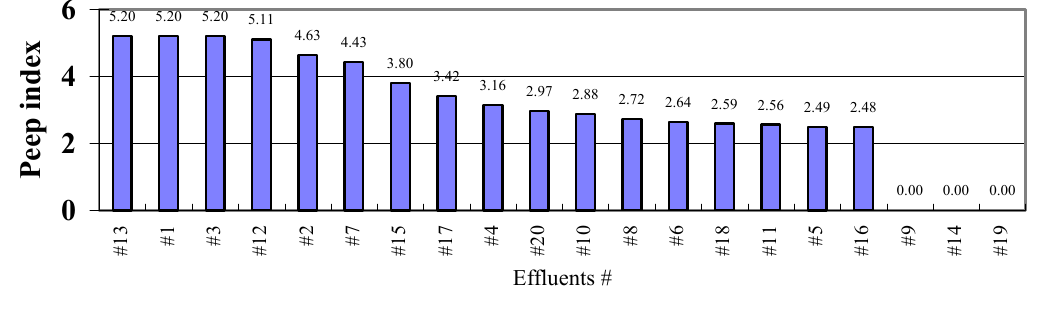
FIGURE 3. PEEP (Potential Ecotoxic Effects Probe) values of 20 Japanese effluents. #1: pulp and paper, #2: chemical production, #3: pharmaceuticals, #4: surface processing, #5: pharmaceuticals, #6: recycled paper, #7: metal processing, #8: meat processing, #9: sewage treatment, #10: textile, #11: recycled pulp, #12: chemical production, #13: aluminum, #14: semiconductor, #15: chemicals production, #16: aluminum, #17: recycled paper, #18: refinery, #19: laundry, #20: sewage